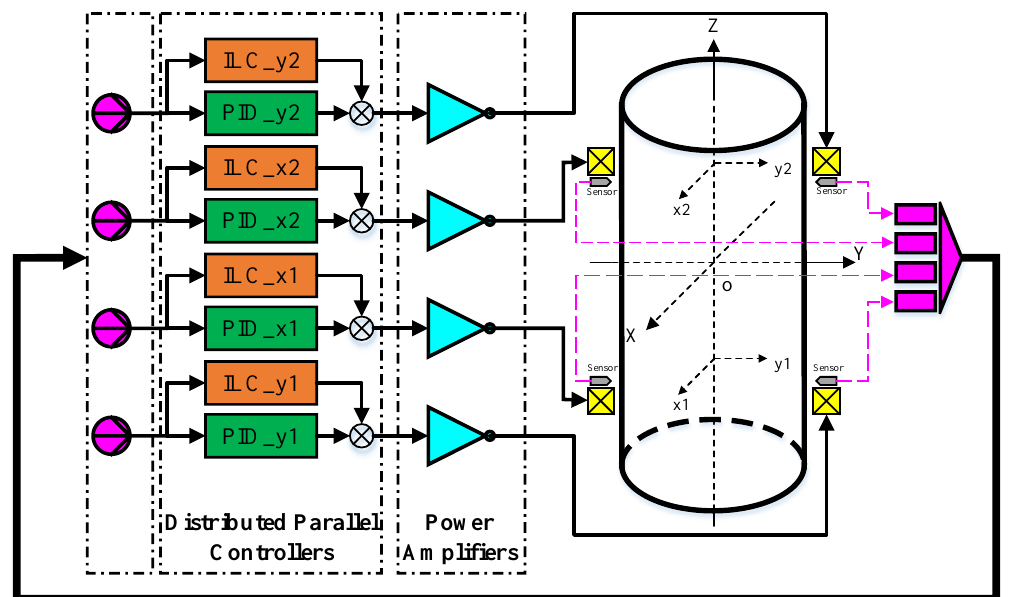
Figure 7. The integrated parallel control system of four radial directions in the AMB bench of PHC- EP.